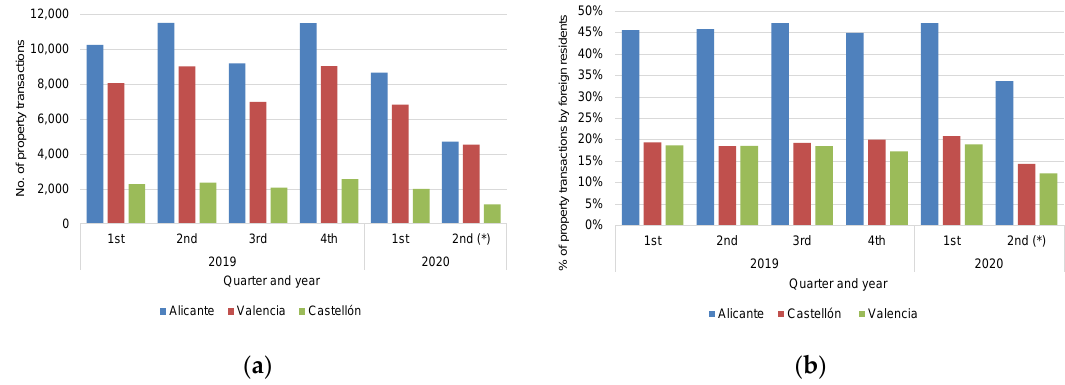
Figure 1. ( a ) Number of real estate transactions by province; ( b ) number of real estate transactions by foreign residents in the Valencian community.